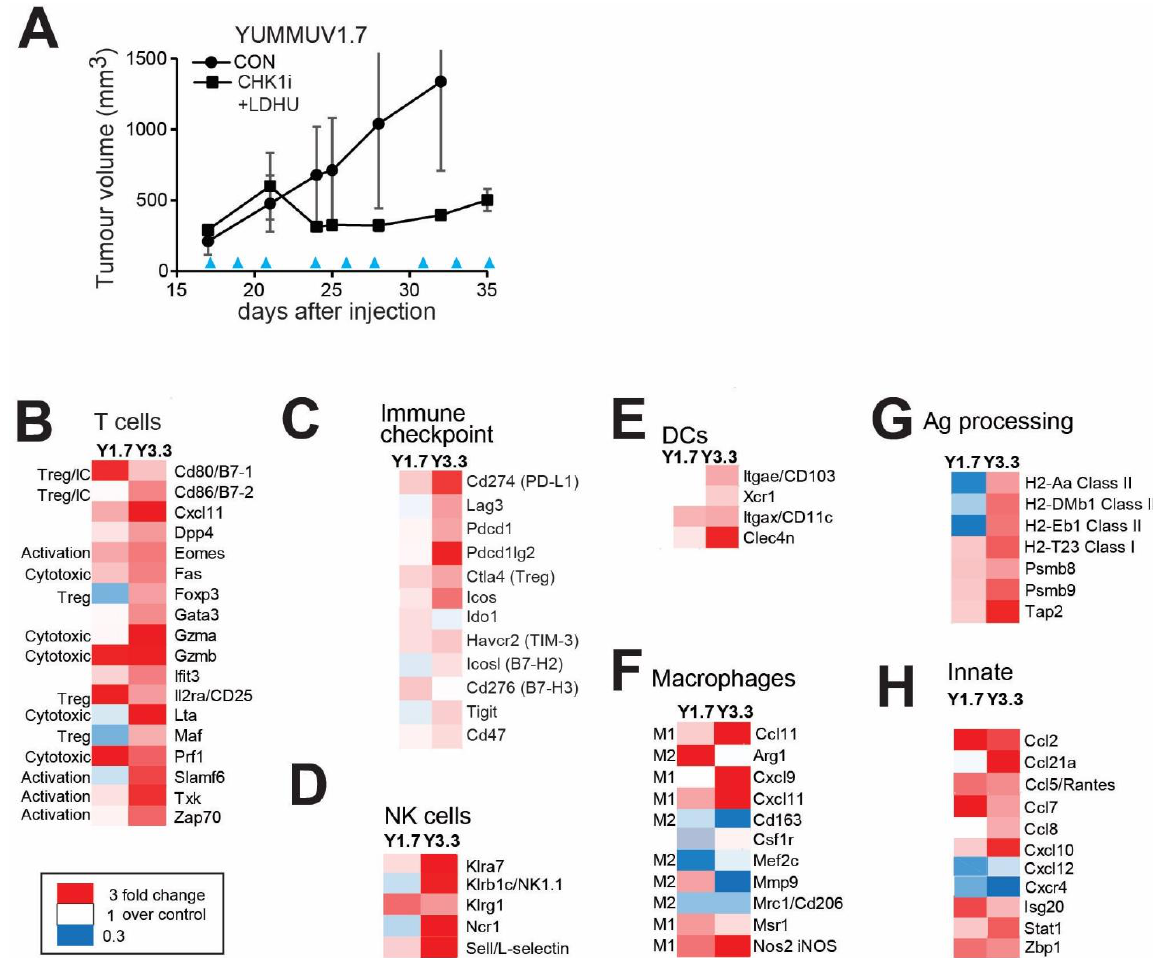
Figure 4. CHK1i+LDHU enhances adaptive and innate immune responses in vivo. ( A ) YUMMUV1.7 mouse melanoma line was established in immune-competent C57BL/6J mice (5 mice/group). When tumours had reached 200–300 mm 3 they were treated three times/week every other day with 50 mg/kg SRA737 + 100 mg/kg HU by oral gavage for three weeks. Tumour volume was measured using callipers. The blue arrowheads indicate the treatment days. ( B – H ) Three tumours for each treatment were harvested 2 days after the final treatment and analysed using NanoString Mouse PanCancer Immune Profiling Panel. Heat maps of the changes in expression compared to vehicle-treated control of significantly altered genes are shown. The transcripts were partitioned into cell types and processes they are associated